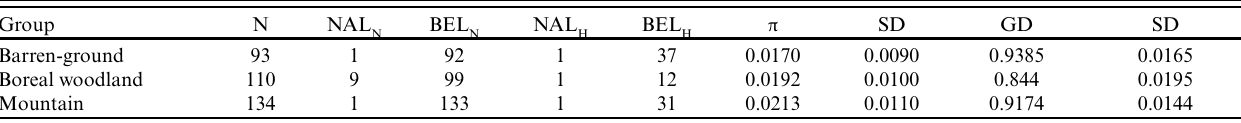
Table 2 . Haplotype (mtDNA) genetic diversity for the three major caribou ( Rangifer tarandus ) groups identified by structure analysis: number of individual caribou samples analyzed for mtDNA (N), number of samples assigned to the North American and Beringian- Eurasian haplogroup lineages (NAL haplogroups, nucleotide diversity (π), and gene diversity (GD) with standard deviations (SD). Group N NAL